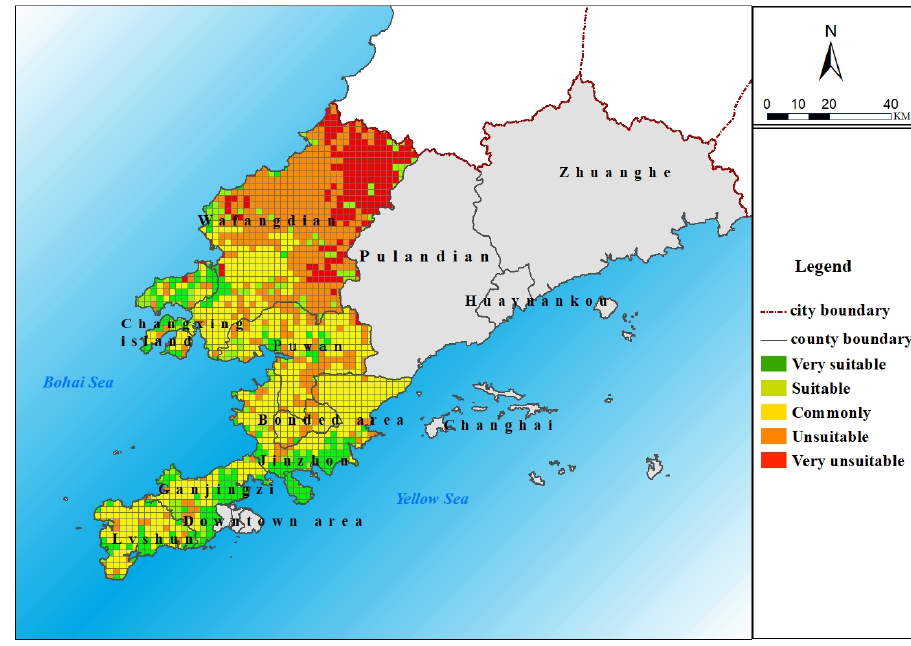
Figure 4. Wind farm suitability area based on the Choquet fuzzy integral method.